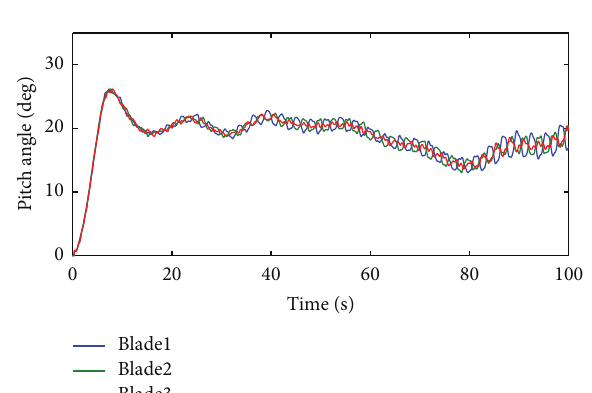
Figure 5: Wave and wind conditions.